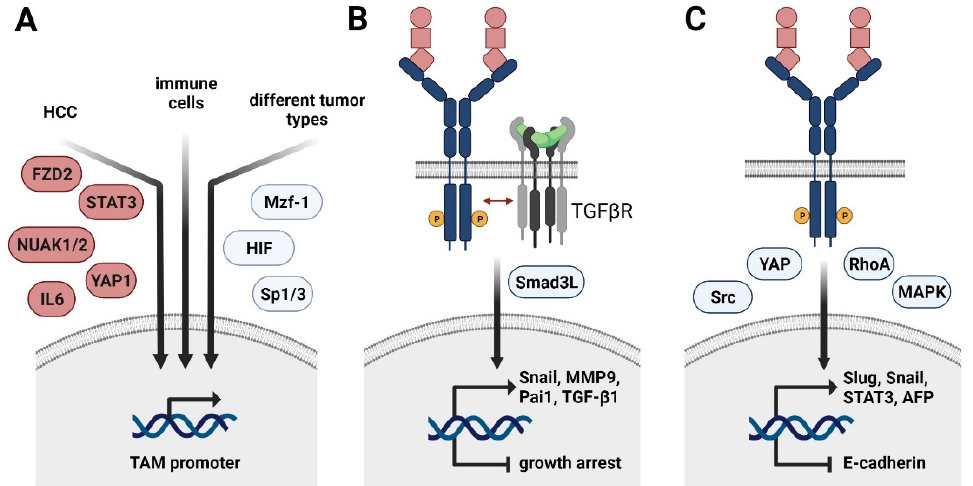
Figure 2. Regulation of TAM receptor expression and its role in HCC progression and EMT. ( A ) Transcriptional control of Axl expression in cancer cells of HCC (left arrow), immune cells (middle arrow), and various tumor entities (right arrow). FZD2, frizzled-2; NUAK, nuclear serine/threonine kinase; STAT3, signal transducer and activator of transcription 3, YAP1, yes-associated protein 1; Mzf1, myeloid zinc finger 1; HIF, hypoxia-inducible factor. ( B ) Molecular collaboration of Axl and TGF- β signaling in HCC switching from TGF- β -induced growth arrest to TGF- β -mediated cancer progression. Smad3L, linker region of Smad3. ( C ) HCC-specific role of TAM receptors in EMT. YAP, yes-associated protein; MAPK, mitogen-activated protein kinase; AFP, α -fetoprotein. Depending on the cancer entity, Axl expression is further induced by the transcription factors Sp1 and 3 as well as myeloid zinc finger 1 (Mzf1) in colorectal cancer patients (Figure 2A) [64,65]. Hypoxia-inducible factors (HIF)1/2 mediate Axl expression in differ-